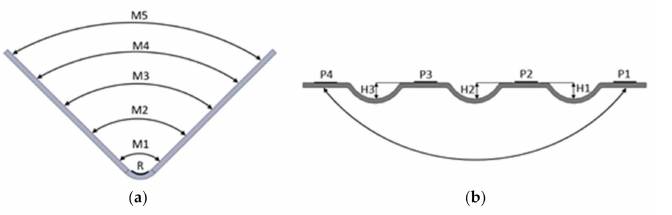
Figure 5. Measurement strategies for sheets formed by ( a ) V-bending and ( b ) groove pressing.